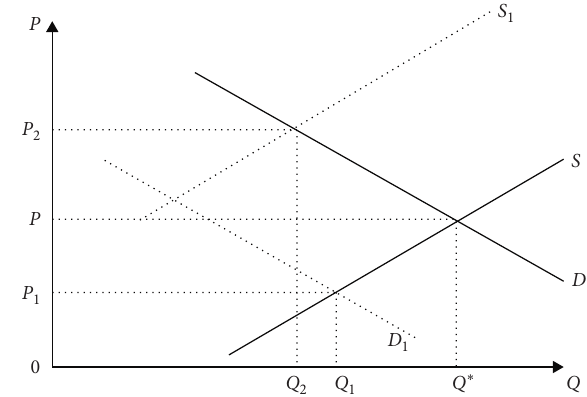
Figure 4: The final price derived by the asymmetrical